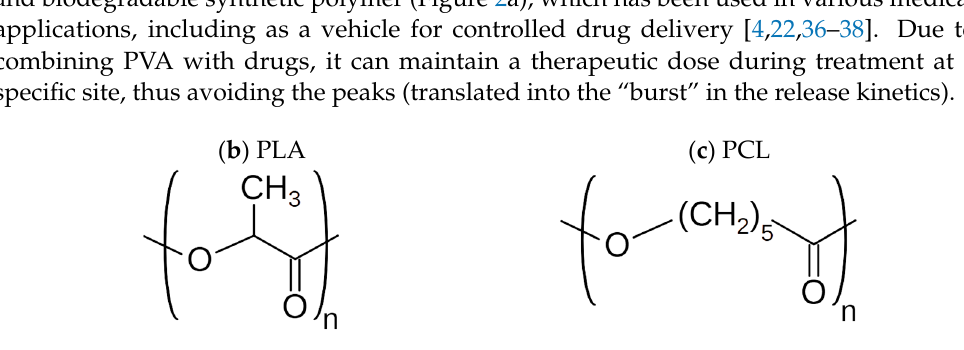
Figure 2. Chemical structure of polymers: ( a ) PVA, ( b ) PLA, and ( c ) PCL.